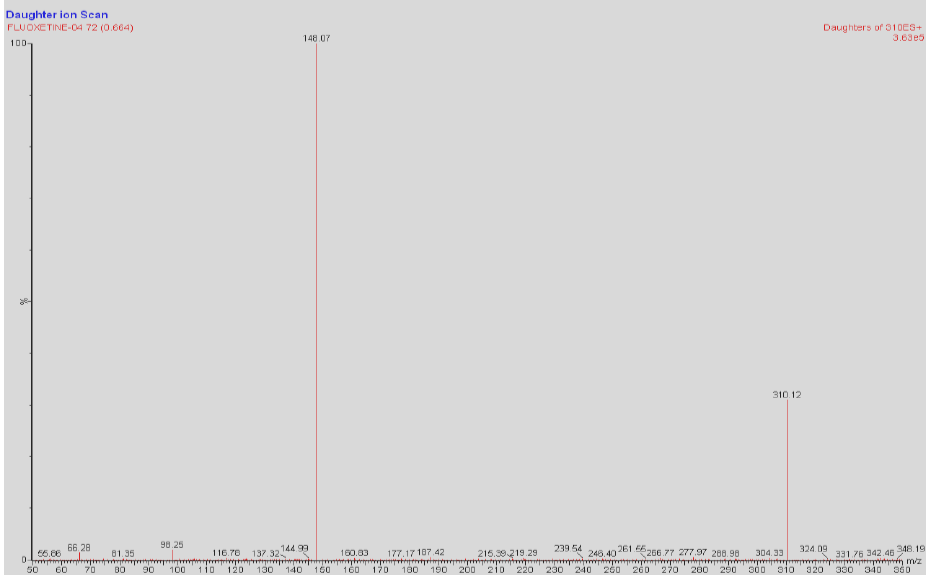
Figure 2. (B). Product ion mass spectra of Fluoxetine ( m/z 310.12→148.07 amu), scan range 50-350